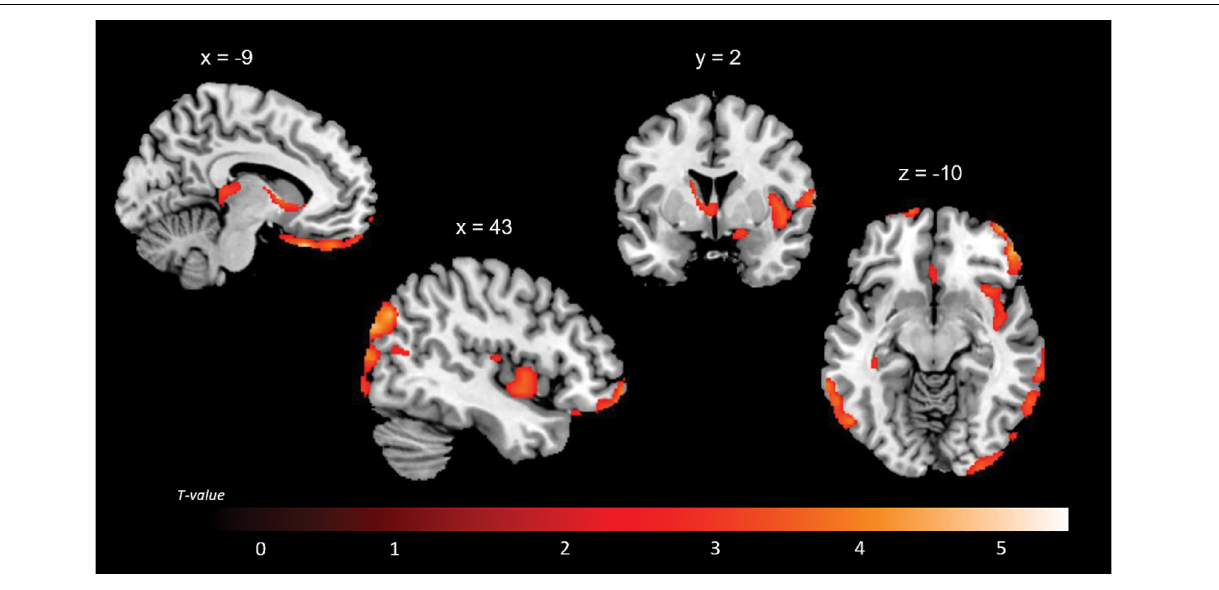
FIGURE 2 | Positive correlations between residual grey matter volume and RMET